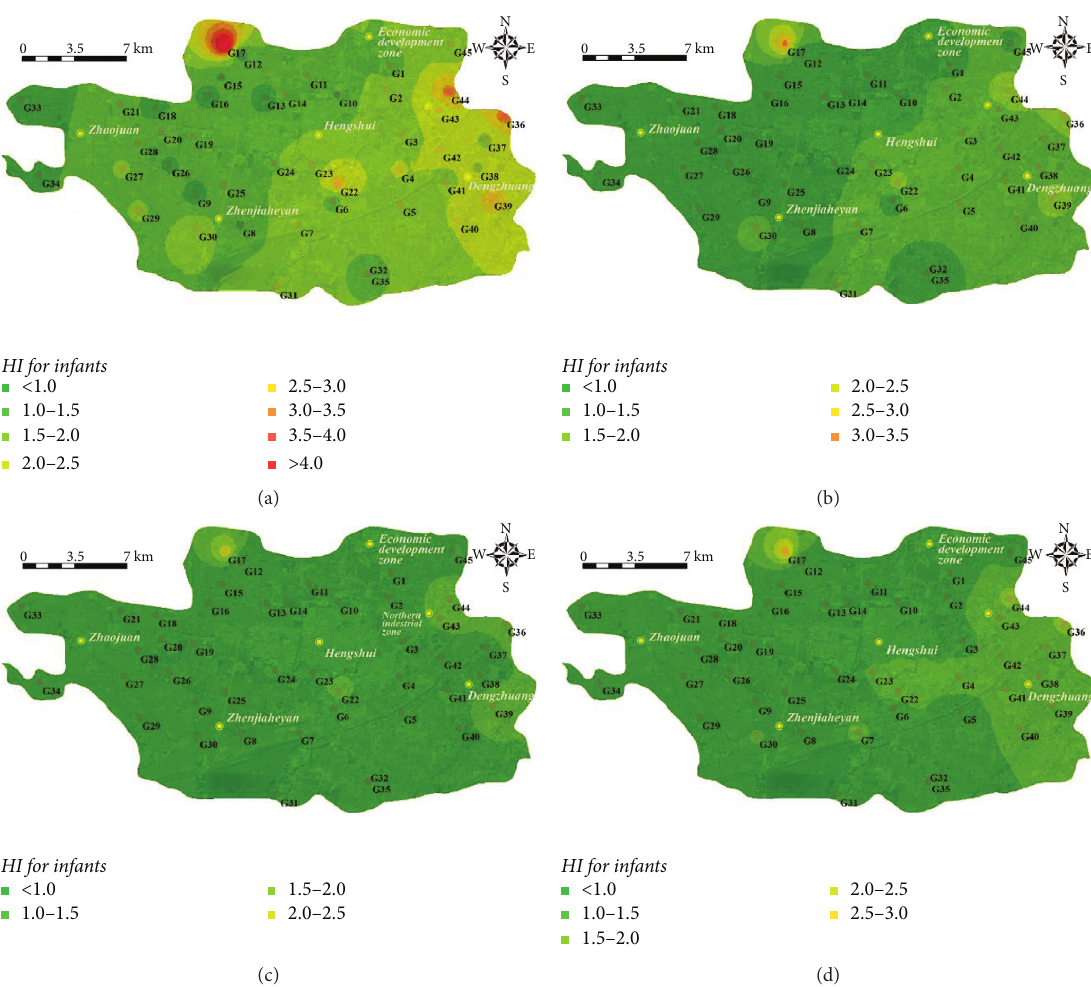
Figure 11: Distribution of the overall noncarcinogenic health risk to (a) infants, (b) children, (c) females, and (d)